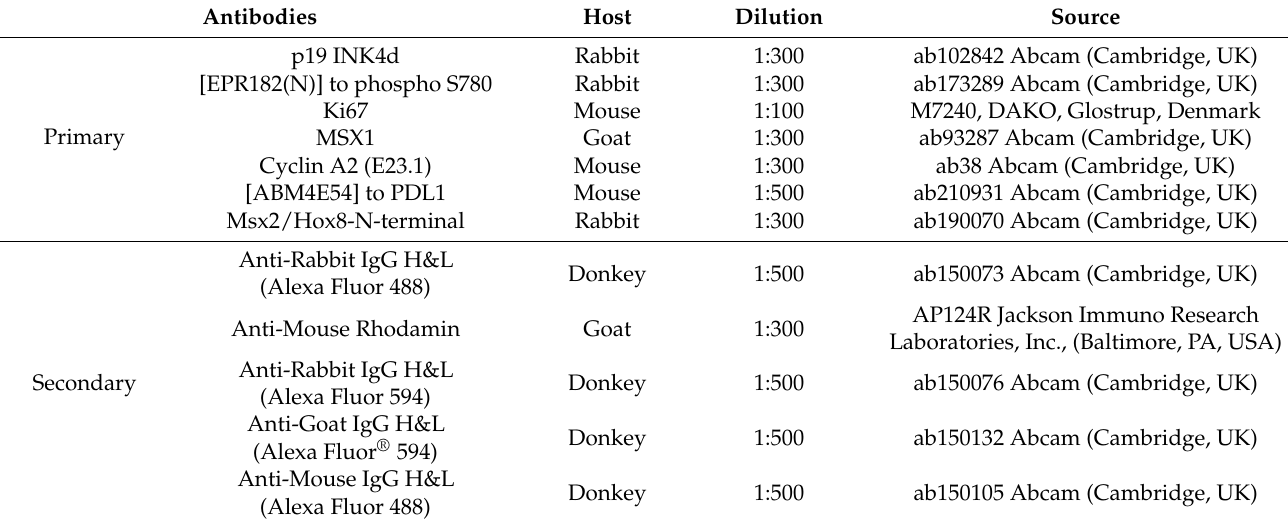
Table 2. Primary and secondary antibodies used in the